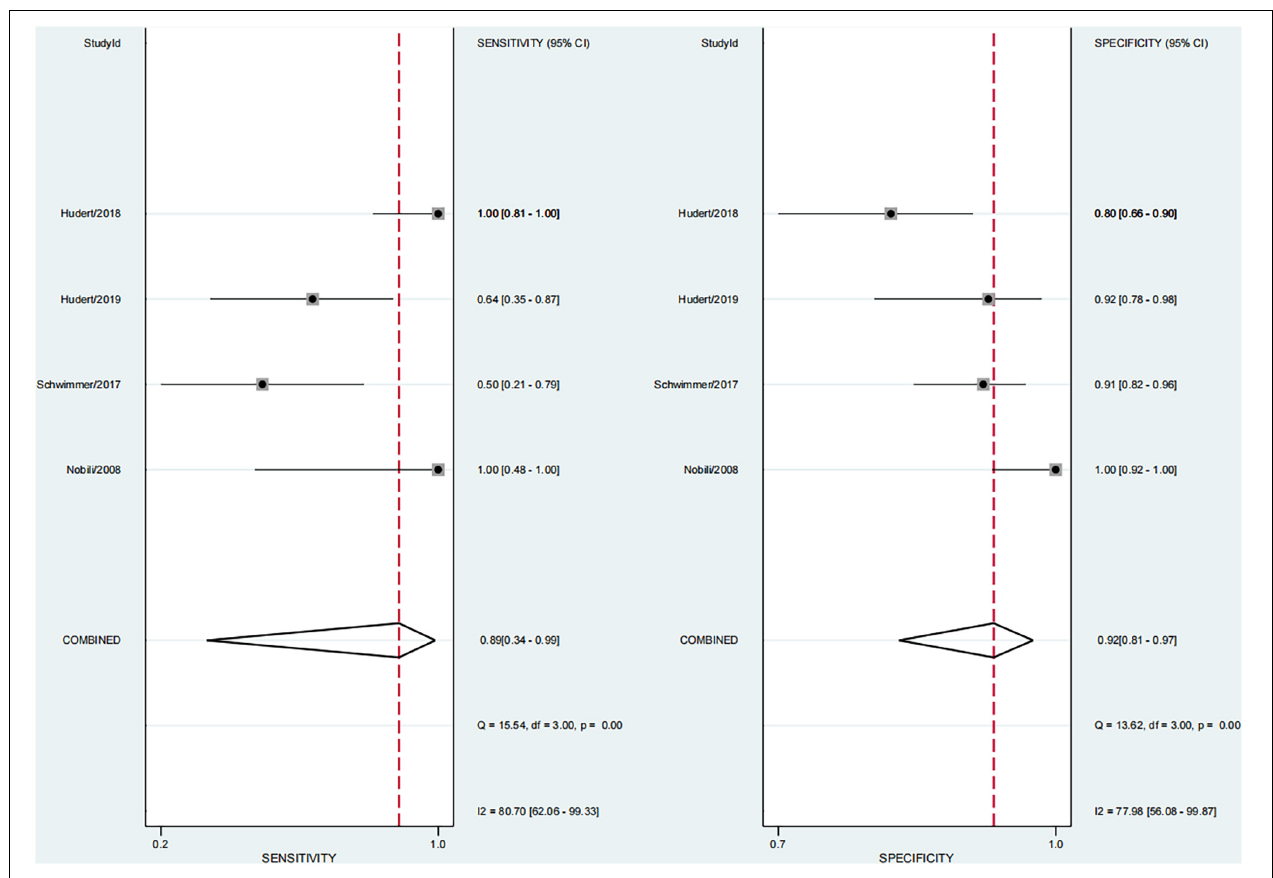
FIGURE 9 | Sensitivity and specificity of elastography in the diagnosis of advanced